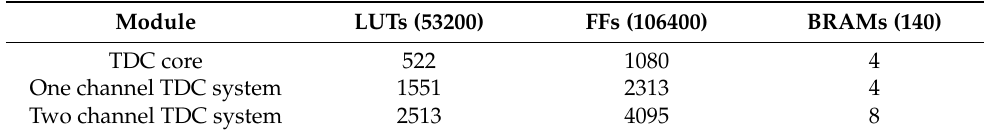
Table 4. The resource utilization of the TDC